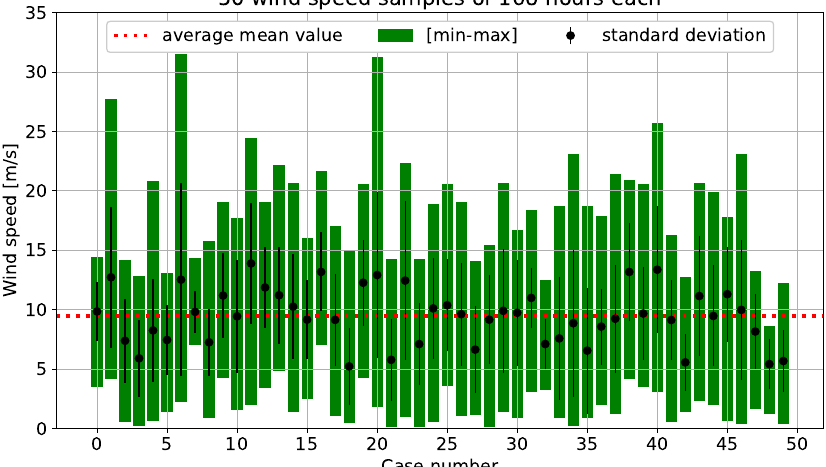
Figure 14. Wind speed variation for 50 samples containing 7 day records at 100 s